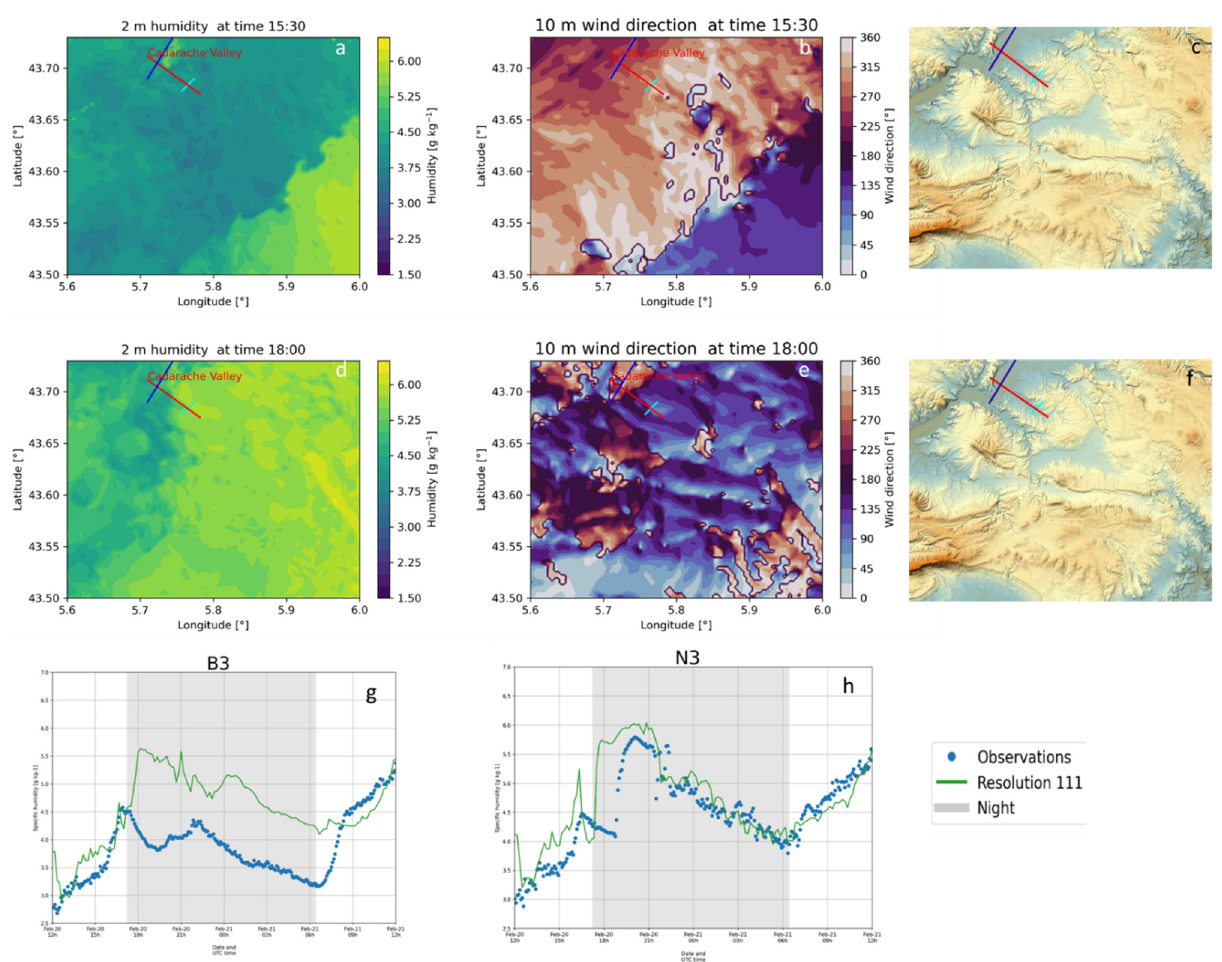
Figure 11. Horizontal field of simulated specific humidity at 2 m (left; a , d ) and wind direction at 10 m (central; b , e ), at 15:30 UTC (top; a , b ) and 18:00 UTC (middle; d , e ). The topography of the surface is recalled on the right ( c , f ). Bottom ( g , h ): time series of specific humidity observed (blue dots) and simulated (green lines) at the bottom of the valley (site B3, left), and at the northern top of the cross-valley axis (right). The blue, red, and cyan lines mark the location of the cross-sections presented in Figure 12. Note that the cross-section represented by the blue line extends beyond the border of the plot.